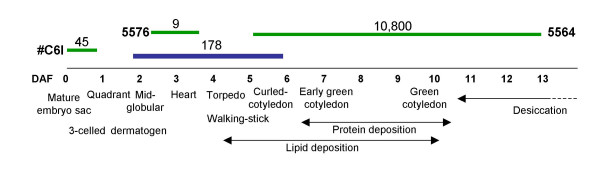
Overview of EST libraries from isolated immature Arabidopsis seeds. At the top, a representation of the available EST collections extracted from immature seeds. Lines in colour represent the period of development covered by the library. The library code according to the TIGR Arabidopsis Gene Index ( [29]) is indicated next to the line. The number of ESTs available from the corresponding library is indicated above the line. Green lines correspond to previously existing EST collections, and the blue line corresponds to the new library described here. At the bottom, the stages of embryo and seed development, related to days after flowering (DAF), is shown [49]. The main processes associated with seed development are indicated.